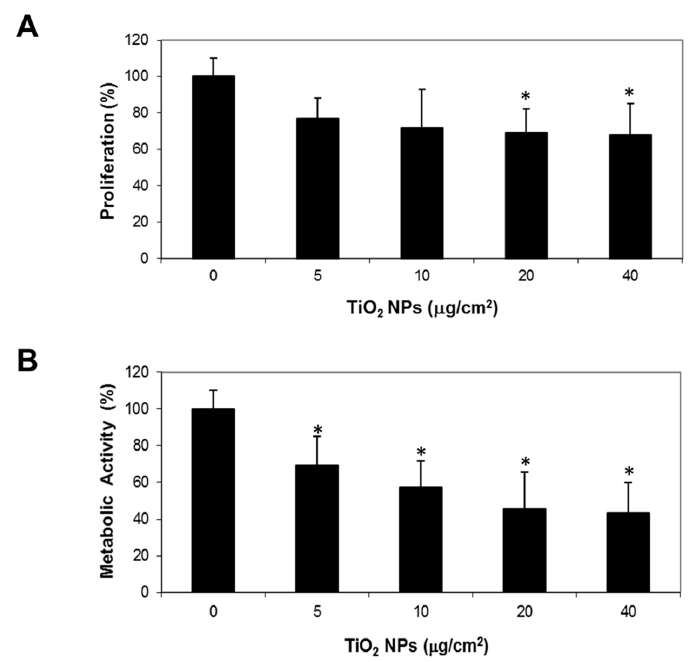
Figure 2. TiO 2 NPs treatment inhibited cell proliferation and decreased metabolic activity. H9c2 cells were treated with different TiO 2 NPs concentrations (5, 10, 20, 40 μ g/cm 2 ) for 48 h. Cell proliferation was evaluated by crystal violet staining and viability by MTT reduction. Results were expressed as mean ± standard deviation (SD) of three independent experiments ( n = 15). * Significant difference between control (untreated) and treated cells ( p < 0.05).